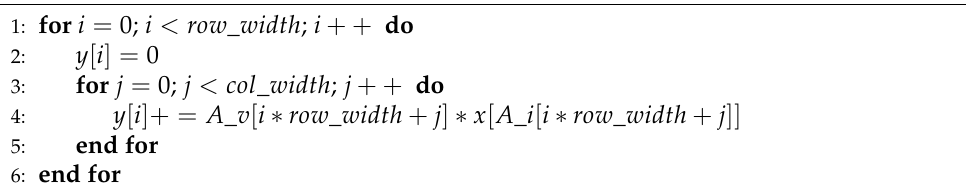
Figure 1. SpMV calculation and ELL storage format. Algorithm 1 SpMV Algorithm of ELL Storage